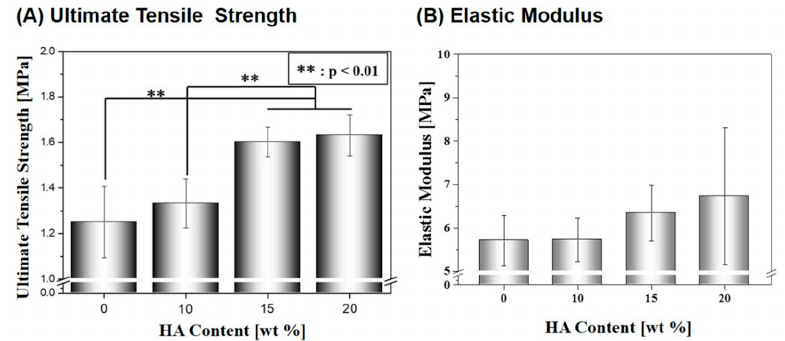
Figure 6. ( A ) Ultimate tensile strength and ( B ) elastic modulus of the macro/micro-porous PCL/HA composite scaffolds (HA content = 0 wt %, 10 wt %, 15 wt %, and 20 wt %).